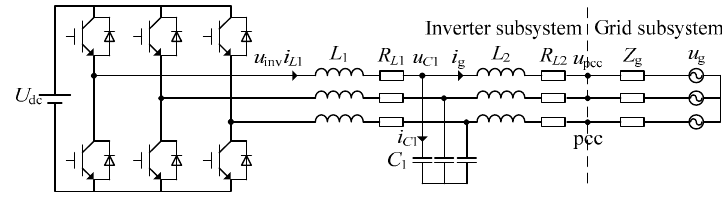
Figure 1. Three-phase grid-connected system.